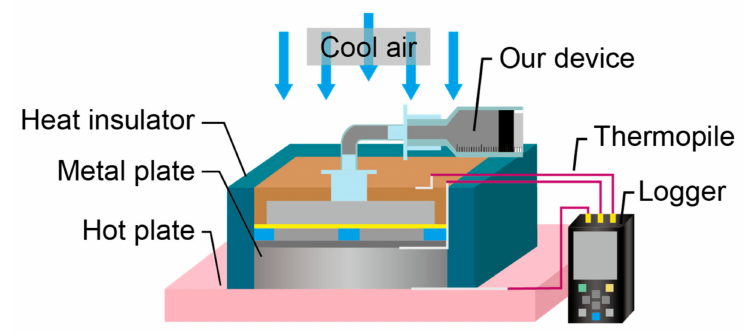
Figure 5. Experimental setup for measurement of thermal